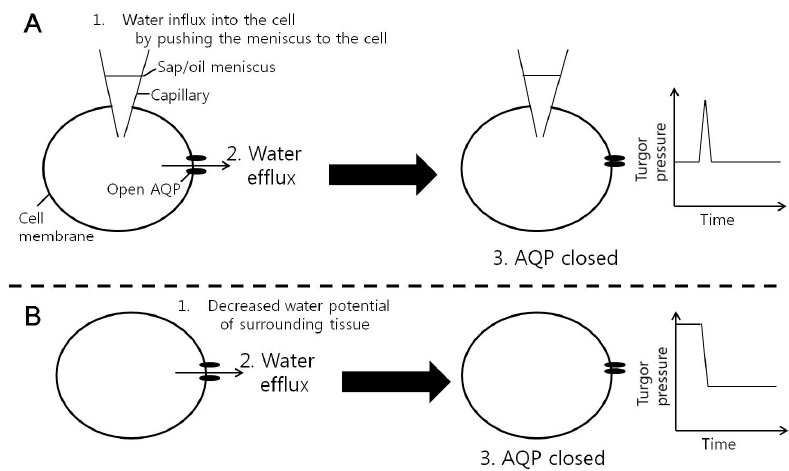
Figure 7. Energy injection model of the gating of aquaporins (AQPs) in membranes of corn cells by water flow passing the AQPs. ( A ) Pressure pulse effect in Wan et al. [24]. Moving the position of meniscus between sap and oil in a micro capillary of a cell pressure probe could produce a big pressure pulse and water flow through the AQPs. The water flow might inject energy to the AQP and cause a reversible mechanical deformation of the protein resulting in the closure of the channel. ( B ) In the present study, when water flow was produced by reducing the water potential in the surrounding leaf tissue by decreasing the root pressure, the water flow through the AQPs might close AQPs in the same